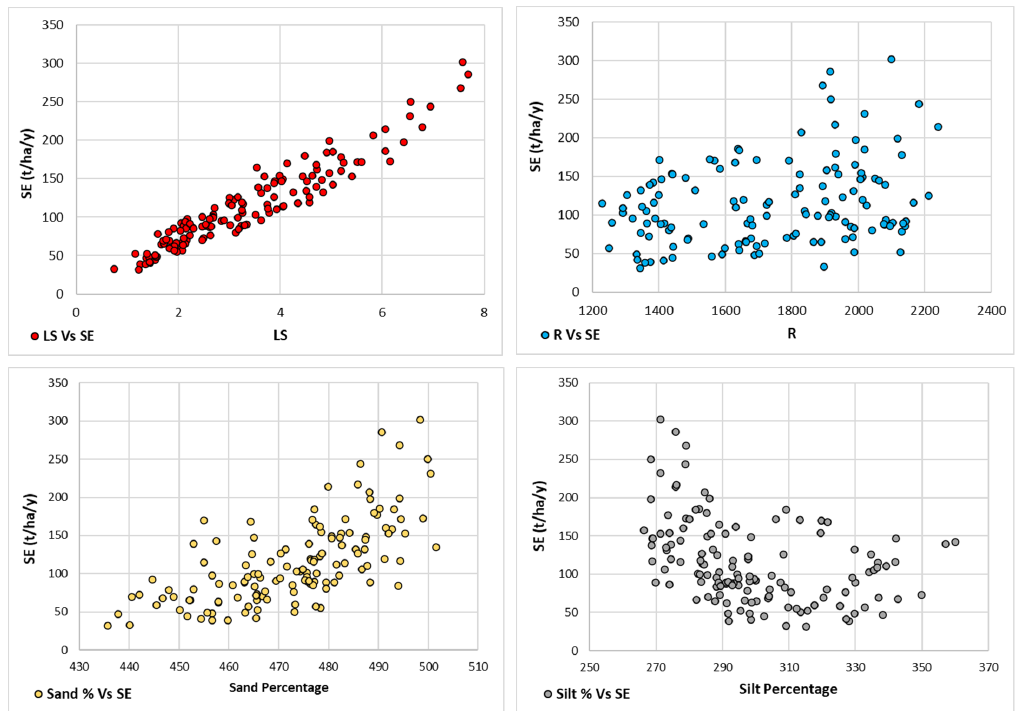
Figure 9. Relation analysis of RUSLE parameters at the sub-catchment level.